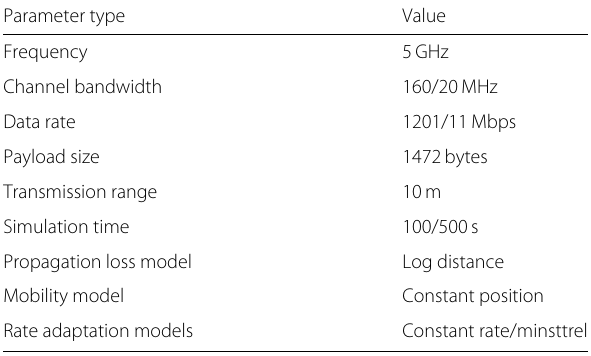
Table 2 MAC layer and PHY layer simulation parameters